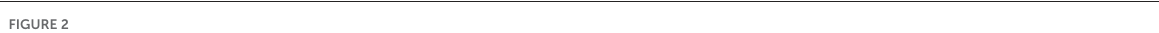
FIGURE2 RT-qPCR analysis. ( B , top) The total cellular lysates were subjected to western blot analysis. ( C , middle and bottom) The cellular (middle) and secreted (bottom) HBV DNA levels were quantified by qPCR analysis. The level of siNC in the control sample is defined as value 1. (D) Cells were transfected with the pgRNA reporter (pCMV1.2xHBV/NL) and the helper plasmid (pcDNA-CP), and siEPN3. Three days later, cells were harvested and subjected to luciferase assay. The NL activity of siNC in the control sample is defined as value 100. (E-I) Cells were transfected with pPB and the FLAG-EPN3 expression vector, and harvested 72h after transfection. (E) EPN3 overexpression was validated by Western blot. (F–H) The levels of cellular HBV RNA (F) , cellular HBV DNA (G) , and supernatant HBV DNA (H) were determined by RT-qPCR and DNA-qPCR. (I) The levels of supernatant HBsAg were measured by ELISA. The level of the empty vector is defined as value 1. (J) Cells were transfected with the EPN3, pgRNA reporter, and helper plasmids, and subjected to luciferase activity. The NL activity of the empty vector transfectant is defined as